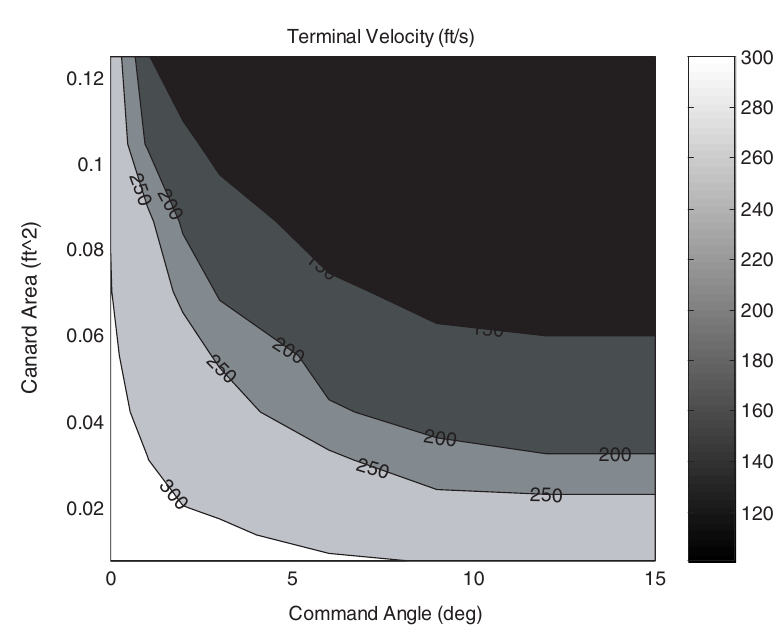
Fig. 13. Flight time vs. canard area and canard command angle.